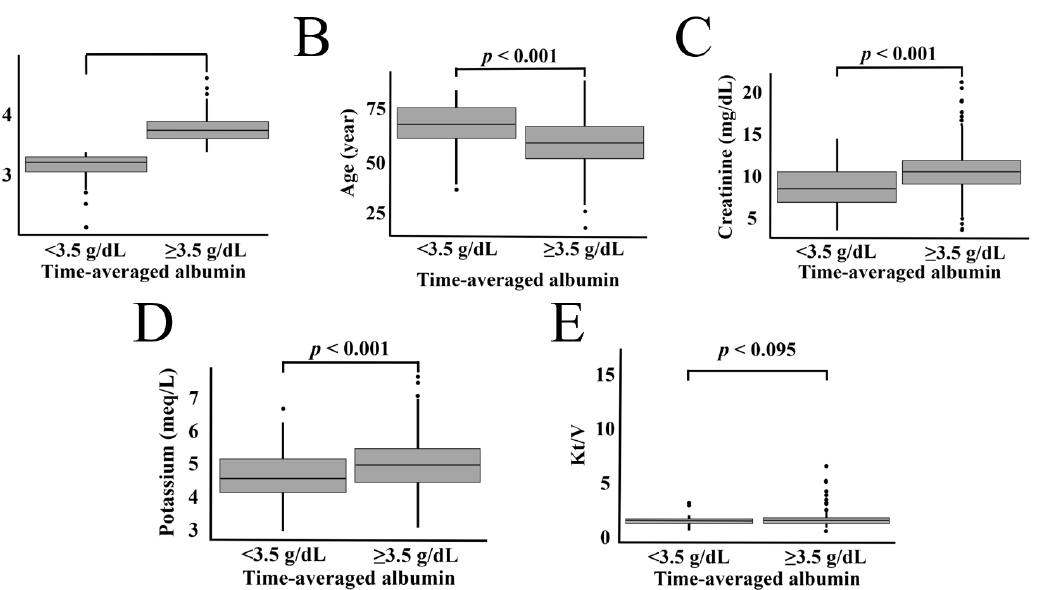
Figure 4. Boxplot of albumin, age, creatinine, and potassium levels in different TSA categories. ( A ) Albumin, ( B ) age, ( C ) creatinine, ( D ) potassium levels, and ( E ) Kt/V.